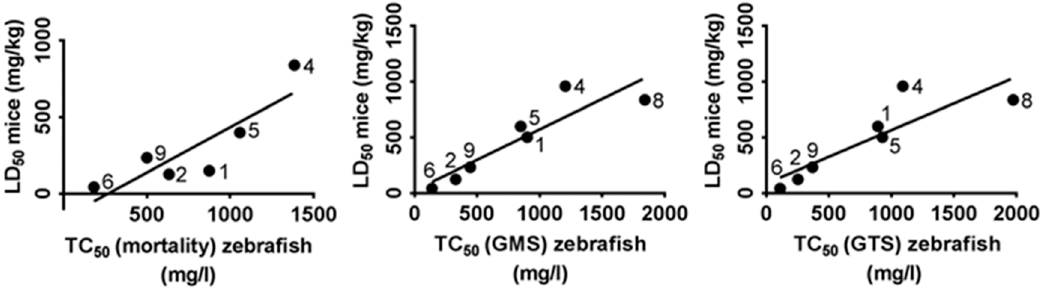
Figure 5. Correlation between TC 50 (Toxic Concentration, 50%) of zebrafish ( X -axis) and LD 50 (Lethal Dose, 50%) of mice ( Y -axis). The analysis included seven of the nine tested methylxanthines: diprophylline was excluded because the value was too large and pentoxifylline because it was an outlier. Numbers linked to each dot correspond to a methylxanthine compound, as reported in Table 2.